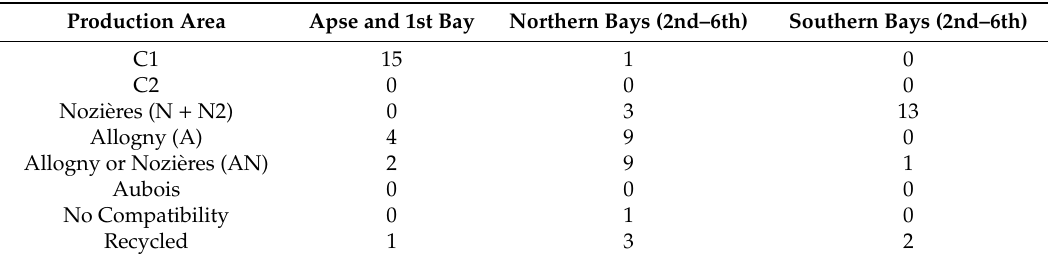
Table 8. Provenance per zones of the iron chain